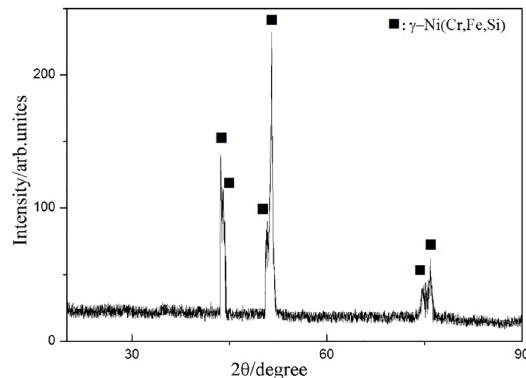
Figure 8. XRD curve of